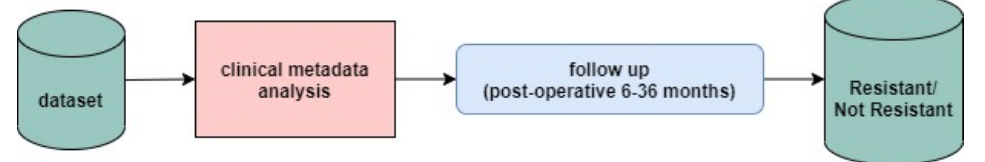
Figure 2. Dividing the processed dataset into a subset based on the clinical metadata for post-operative follow-up parameters.